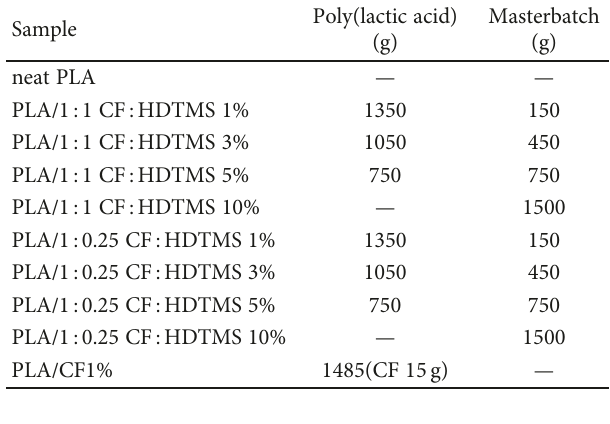
Table 1: Mixing ratio of poly(lactic acid) to masterbatch. Sample